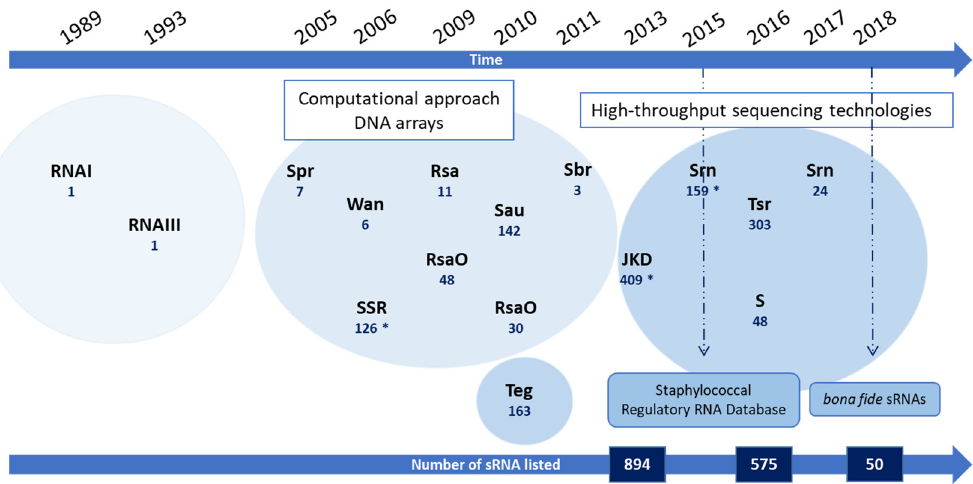
Figure 1. Chronology and classification of the major classes of Staphylococcus aureus sRNAs discovered from the 1990s to nowadays. * indicates that there is no further validation after the identification of a new sRNA group.